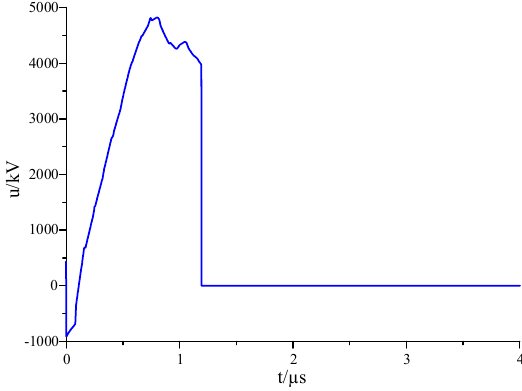
Figure 5. Voltage across the insulator (#3 tower, single-phase back flashover at 177 kA lightning current).